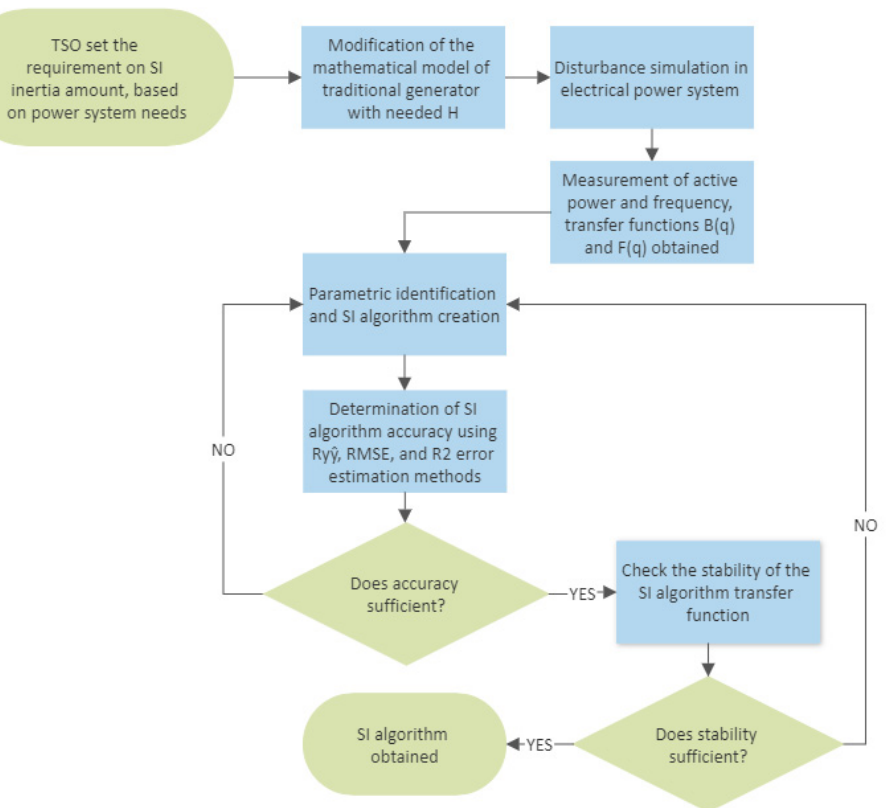
Figure 3. Flowchart of SI algorithm methodology.